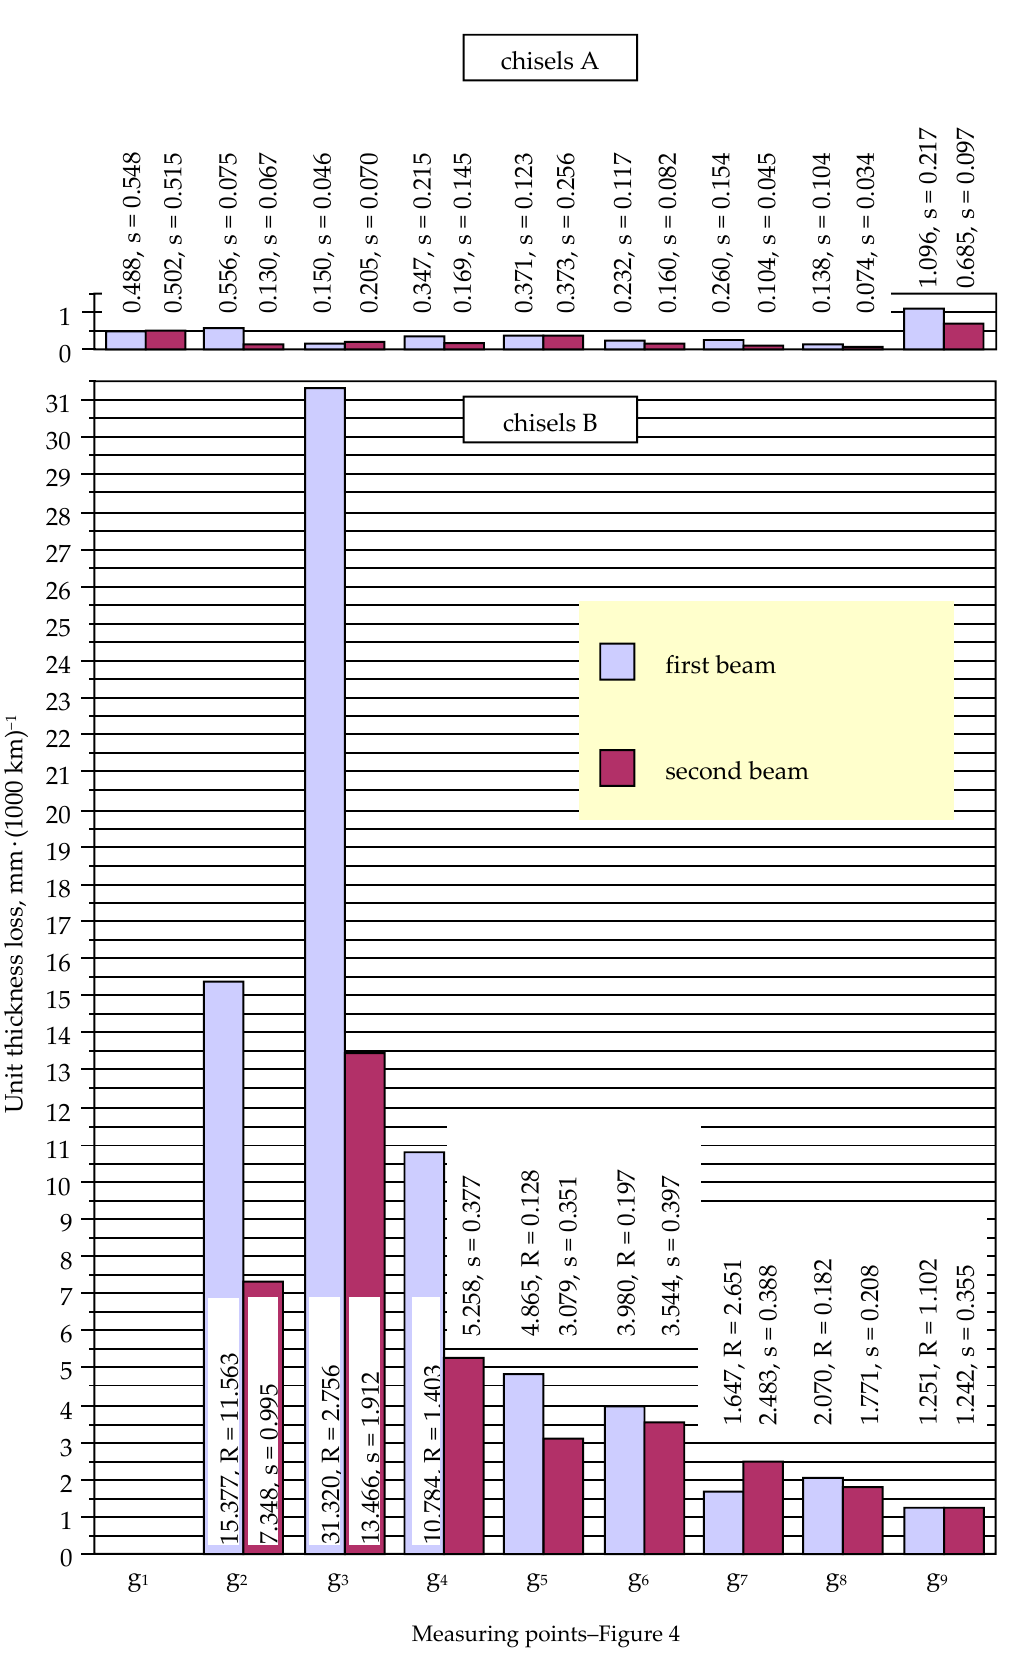
Figure 10. Unit thickness loss of chisels A and B (s, standard deviation; R, range).